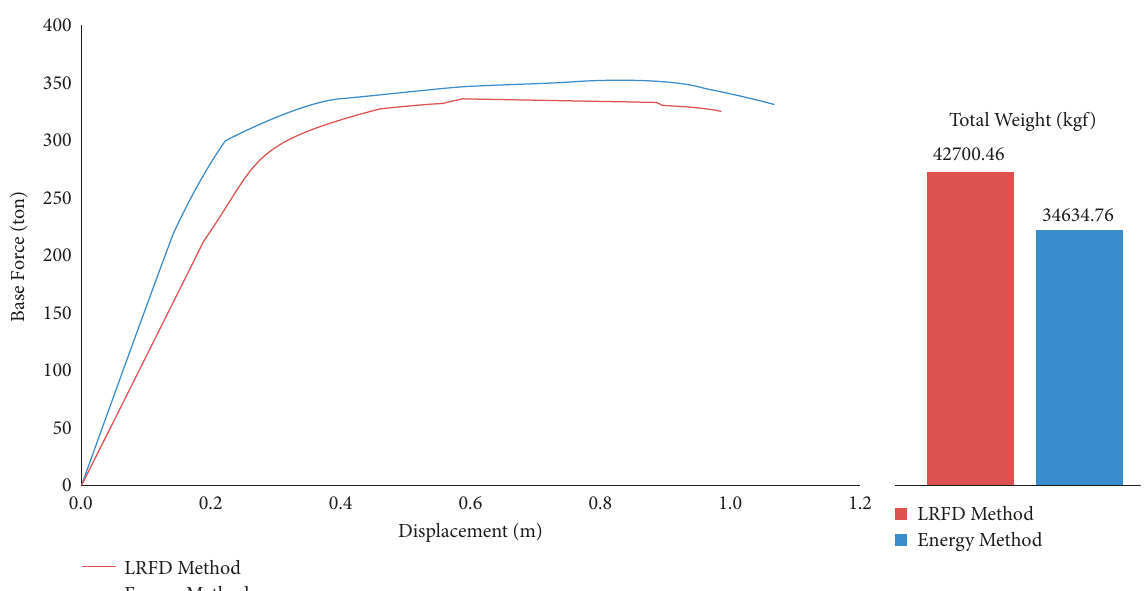
Figure 15: Comparing the push diagrams and the weight of the 8-story steel frame designed by the energy and LRFD methods.